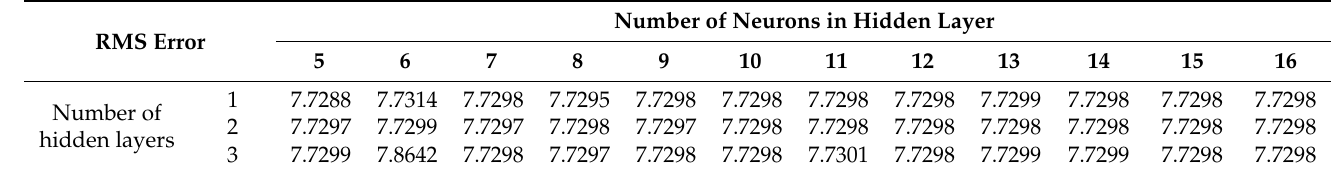
Table 14. RMS error for active power loss estimation for IEEE-34 bus system (case 2).